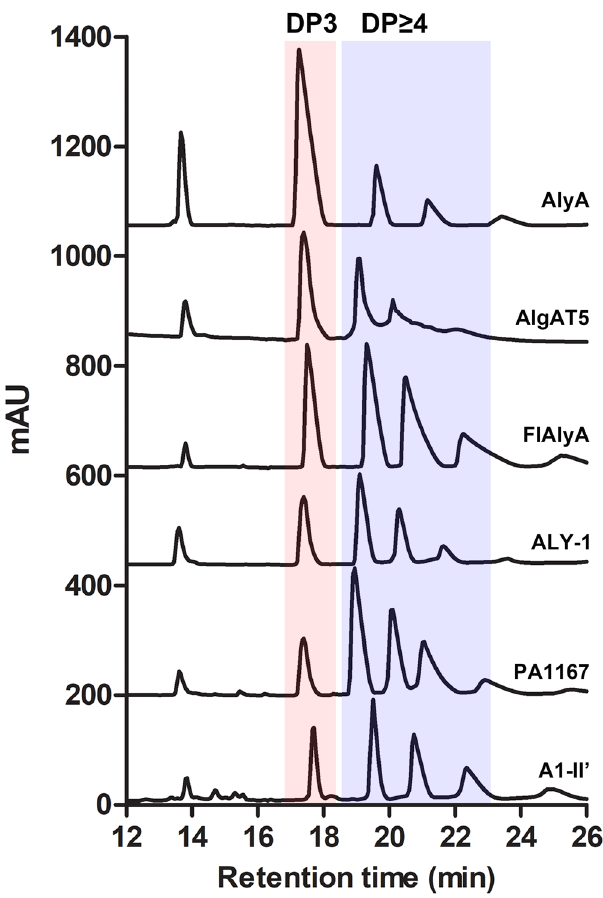
Fig. 7 The products generated by six PL7 alginate lyases were analyzed by HPLC. The main products of these alginate lyases were determined by the quantity of each